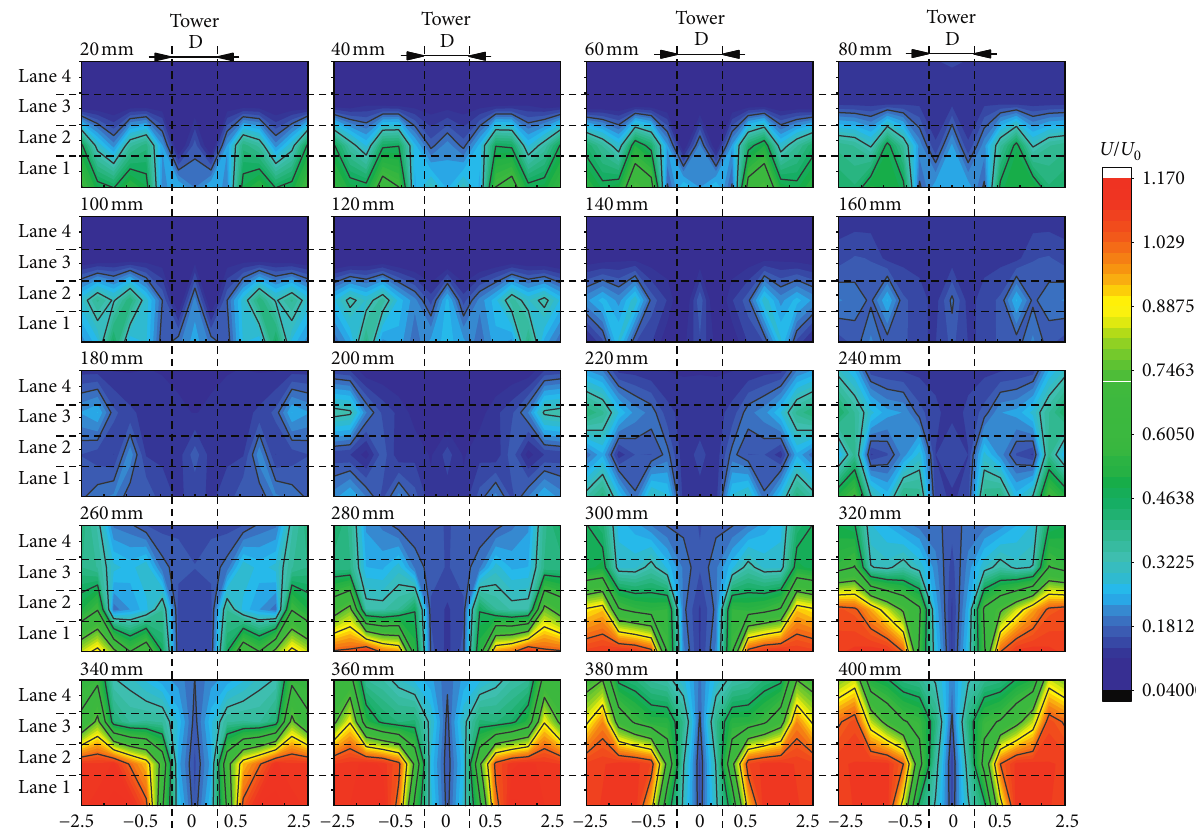
Figure 11: Contours of wind field above the bridge deck in the presence of WB-4